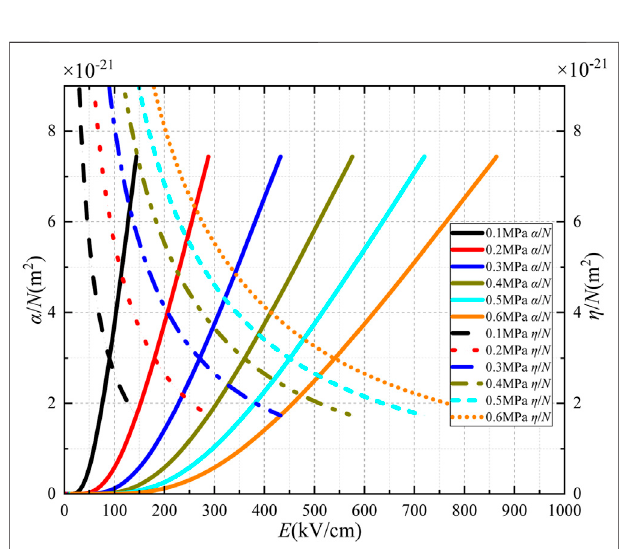
FIGURE 3 | The relationships of α / N and η / N with E under 0.1 – 0.6 MPa.